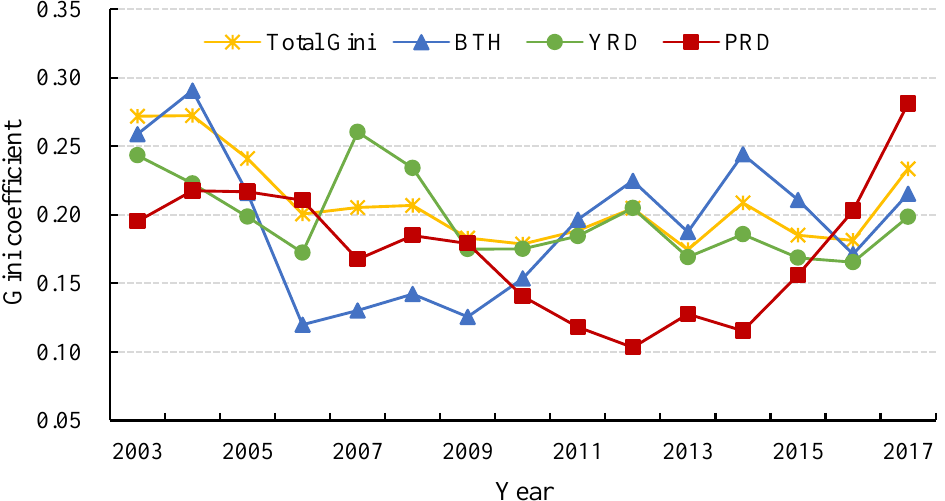
Figure 5. Total and intra-regional Gini coefficient of CEE in China’s three major urban agglomerations from 2003 to 2017.